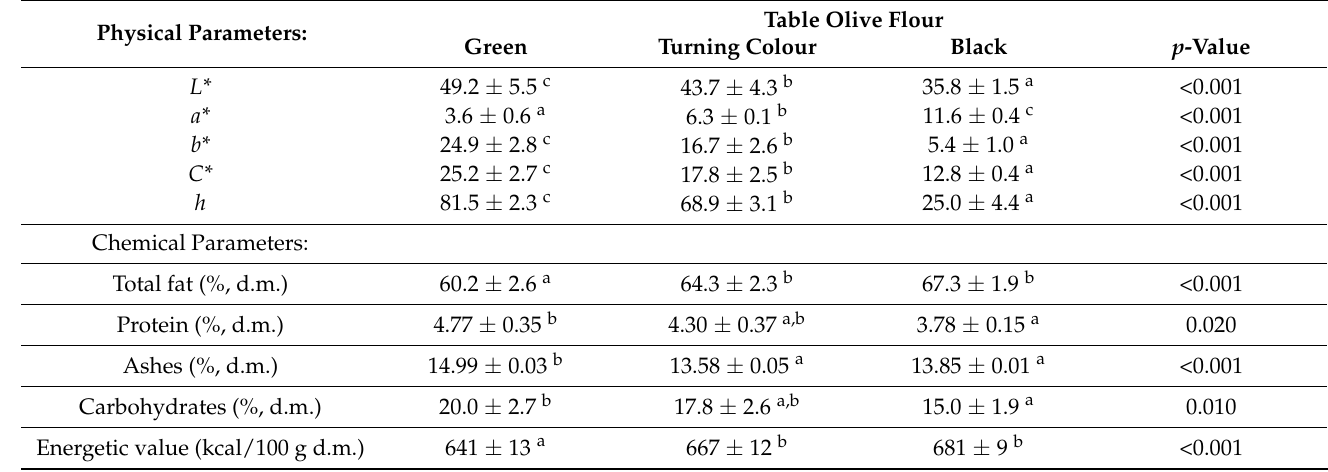
Table 1. Color parameters and nutritional composition (grams per 100 g dry matter) and energy value (kcal per 100 g dry matter) of table olive flours (mean ± standard deviation).